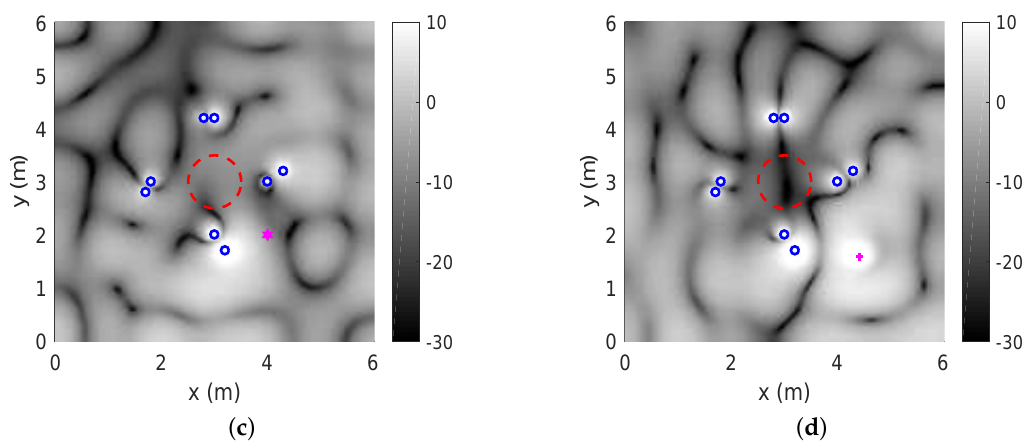
Figure 4. Energy of the residual noise field, when the noise field is generated by one primary source using different methods. Here, pink point is the projection of the primary source on the x-y plane and blue points are the loudspeaker points located on the x-y plane: ( a ) the WDLS method in case 1; ( b ) the WDLS method in case 2; ( c ) the subspace method in case 1; ( d ) the subspace method in case 2.